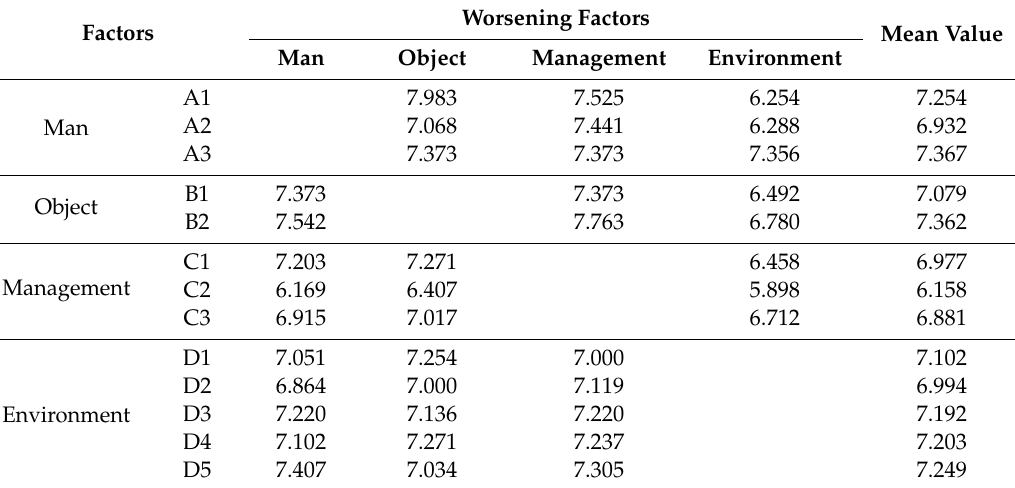
Table 8. Scores of worsening factors.